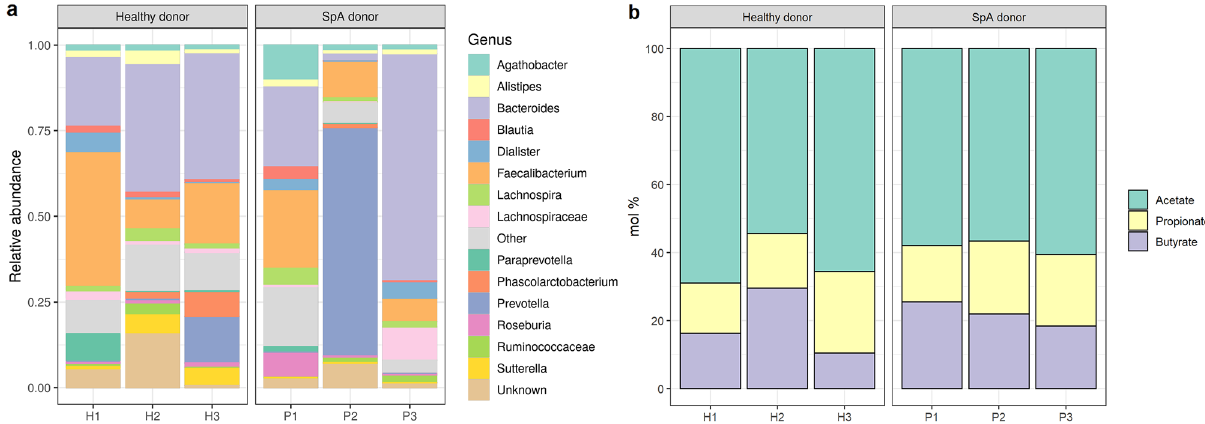
Figure 4. Microbial characterization of fecal slurries at time point zero of host-microbe coincubations. ( a ) Relative abundance of the microbial community composition at genus level. The 15 most abundant genera per donor are displayed. Less abundant genera are grouped into ‘Other’. ( b ) Short-chain fatty acid (SCFA) composition in mol